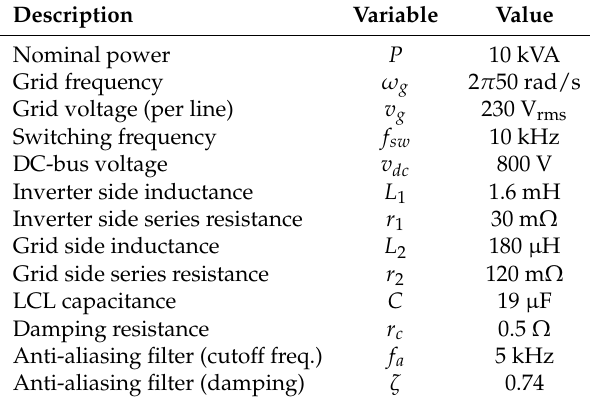
Table 1. Plant parameters.